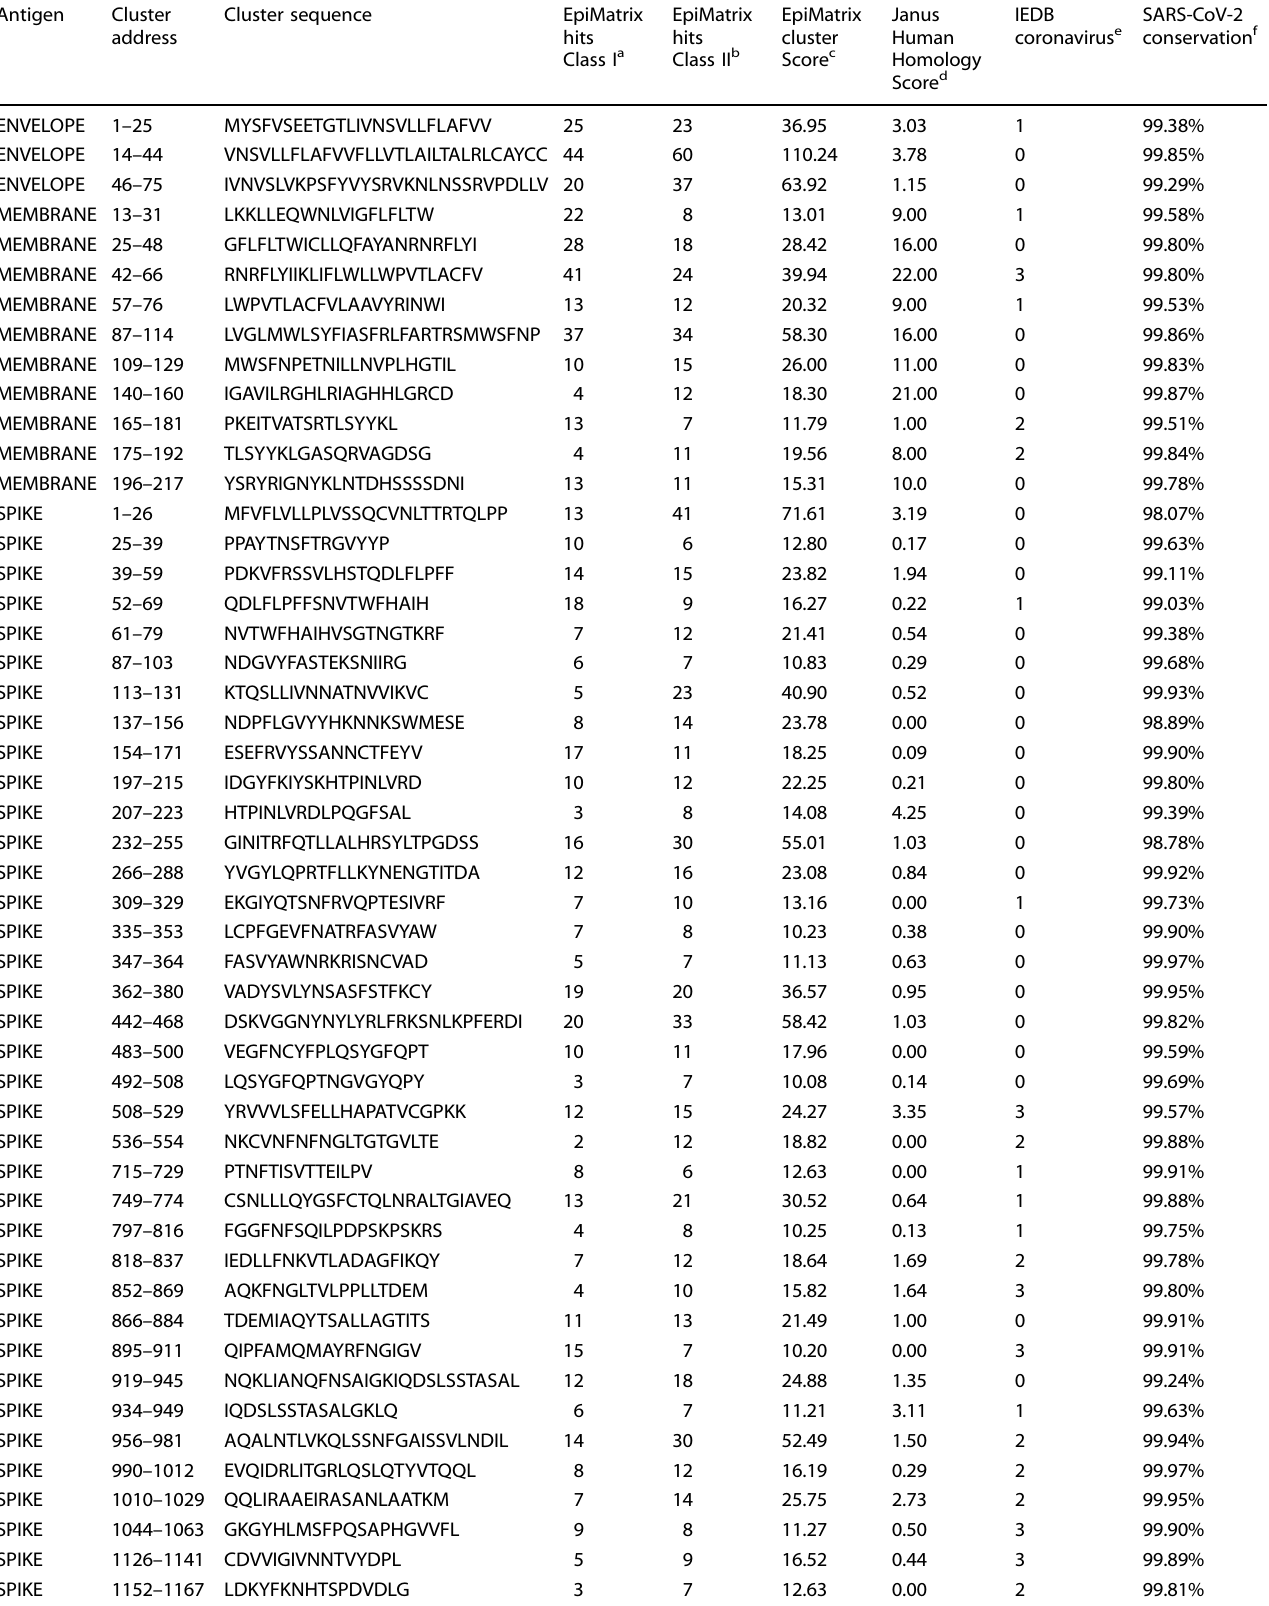
Table 1. Immunogenicity potential and human and coronavirus cross-conservation features of SARS-CoV-2 surface antigen epitope